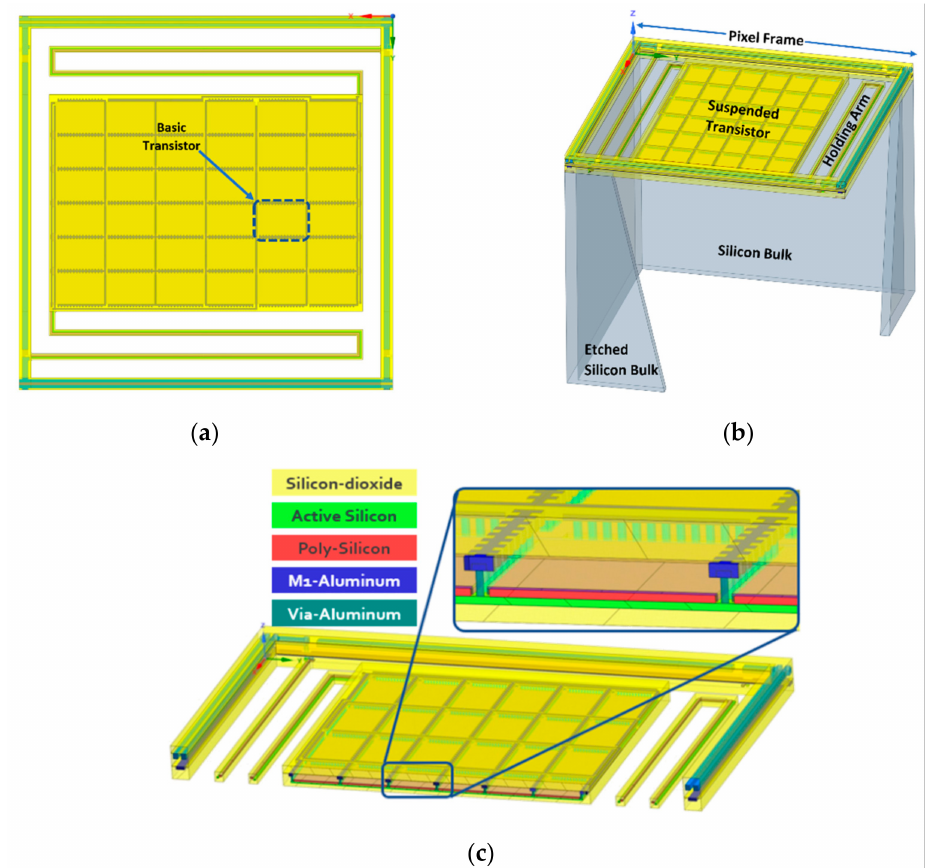
Figure 1. TMOS single nano-machined pixel. ( a ) Overview; ( b ) 3D model; ( c ) cross section of the pixel.